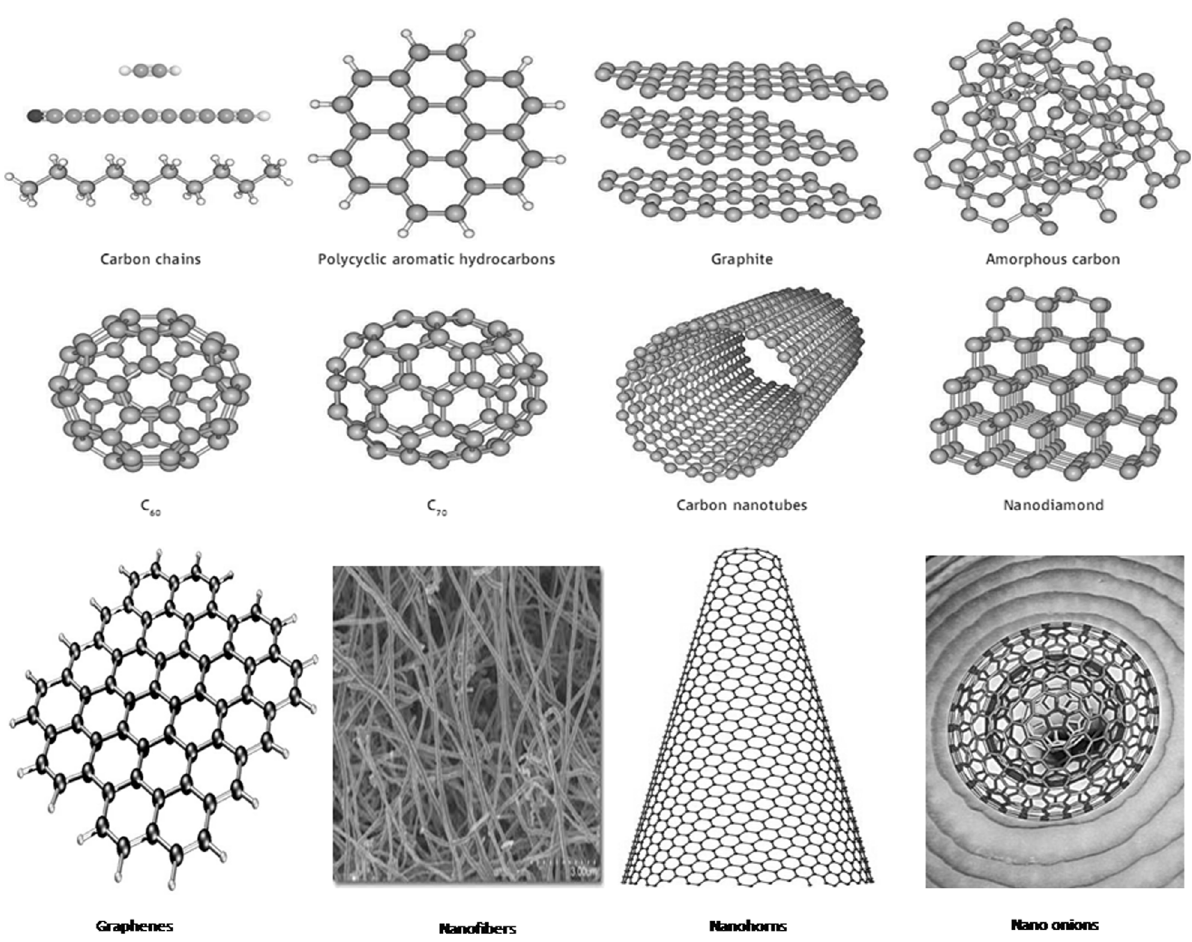
Figure 1. Different forms of carbon nanotropes